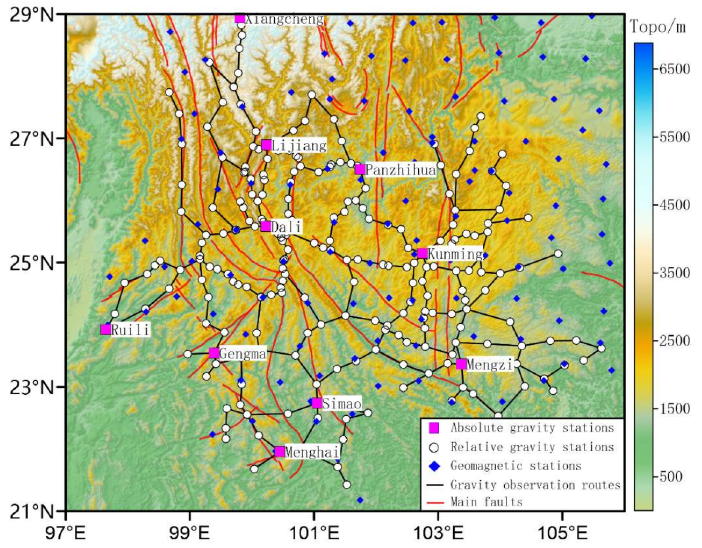
Figure 2. Distribution map of gravity survey points, geomagnetic survey points, and faults in Yunnan